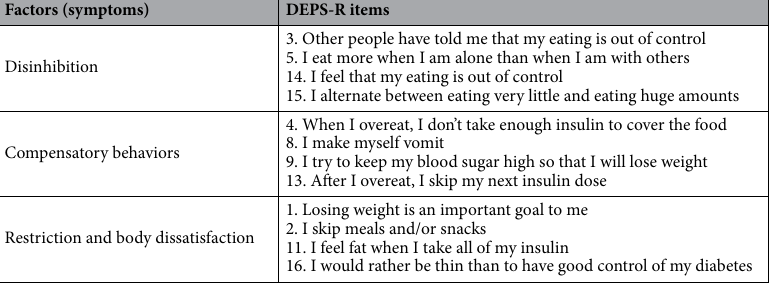
Table 5. Subdivision of DEPS-R items into clinimetric factors (symptoms). Subjects who respond very often/ always to at least one of the four items are considered to have the symptom. Each subject may also have more than one